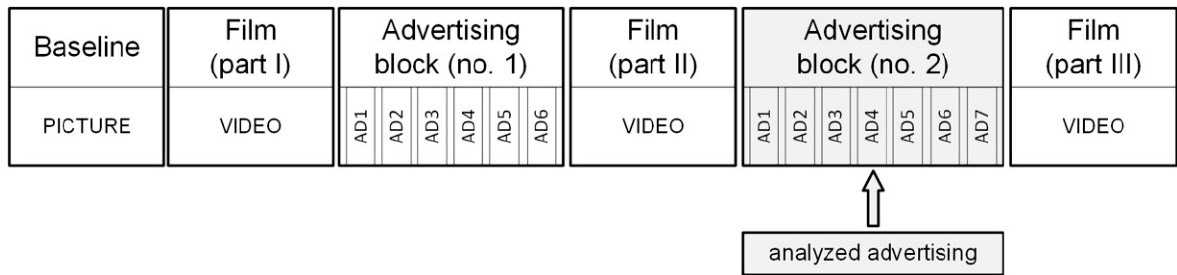
Figure 1. Study protocol structure. The ad under study was placed in the second advertising break.